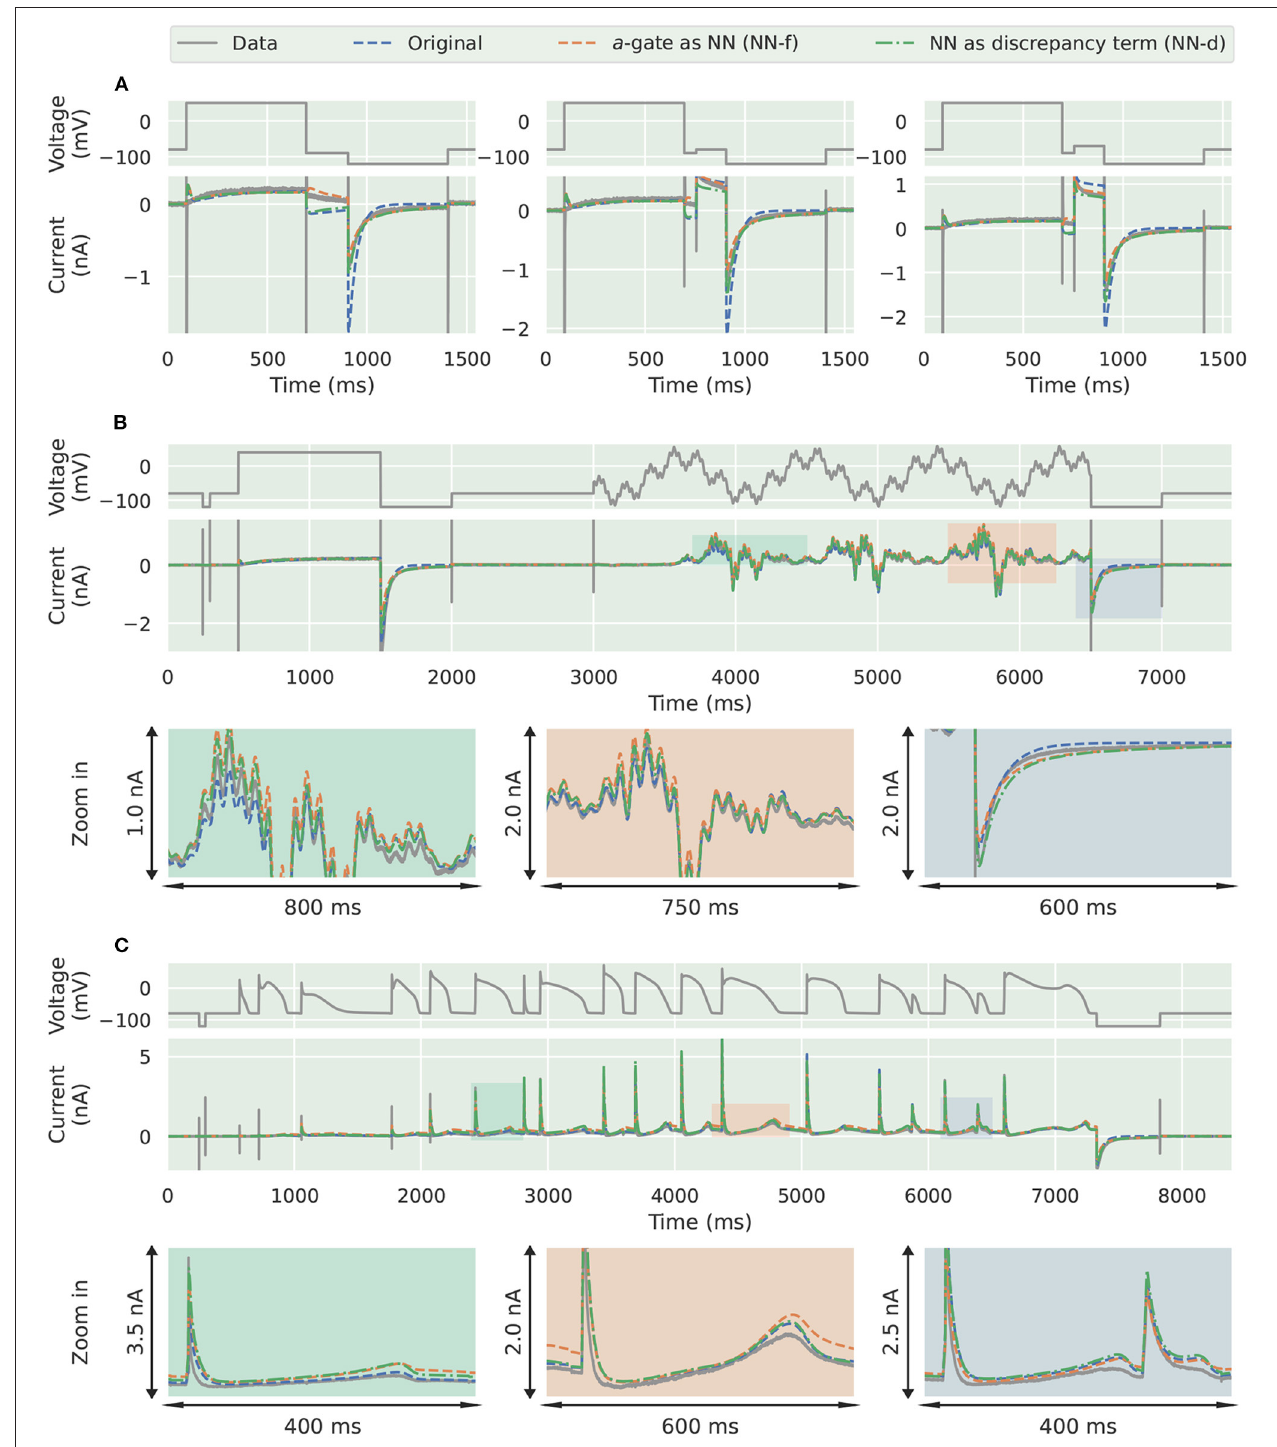
FIGURE 6 | Prediction results for the experimental data from Beattie et al. (2018). Comparison of the experimental data (grey) against the candidate a -gate model (blue), the a -gate modelled using a neural network (NN-f, orange), and the a -gate with a neural network discrepancy term (NN-d, green). (A) Shows a part of the inactivation protocol (Pr4), showing the first three steps of the protocol. (B) Shows the sinusoidal protocol. (C) Shows a protocol consists of a series of action potentials. All figures with a green background are real data examples.